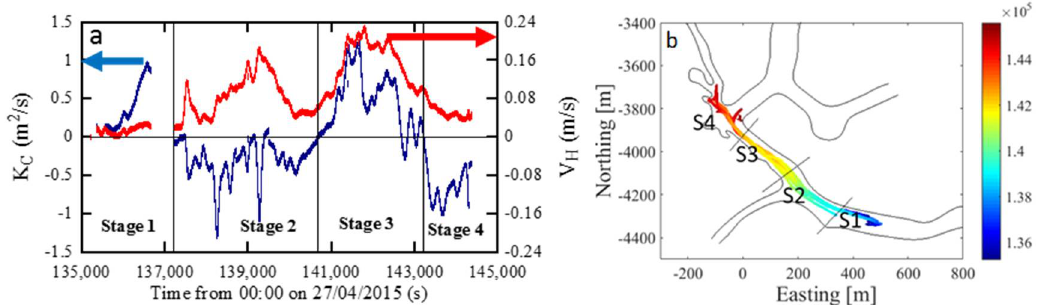
Figure 7. ( a ) Time variation of dispersion coefficient (blue) and centroid velocity magnitude (red) of drifter cluster during open state (E1) during the flood experiment, ( b ) Drifter trajectory coloured by time (s), with vertical lines separating Stages S1–S4 in ( a ) corresponding to cross lines separating S1–S4 in ( b ). Note: the number of active drifter for the calculation was 5–15; periods with drifter numbers, n < 5 are not included.